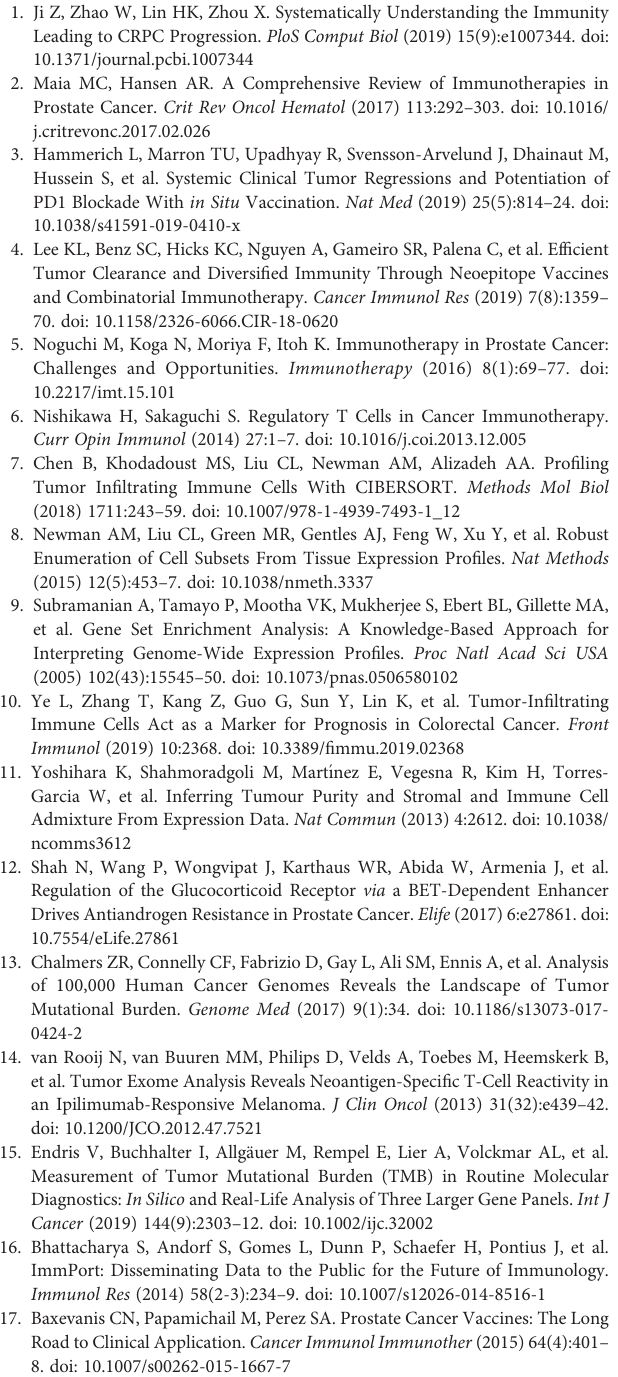
prostate cancer. (C) The LTF gene was explored and veri fi ed by data samples of 33 common tumor types. (D) After overexpression of the LTF gene in PC-3 prostate cancer cells, the expression levels of LTF, JAK, STAT3, and GM-CSF were veri fi ed by Western